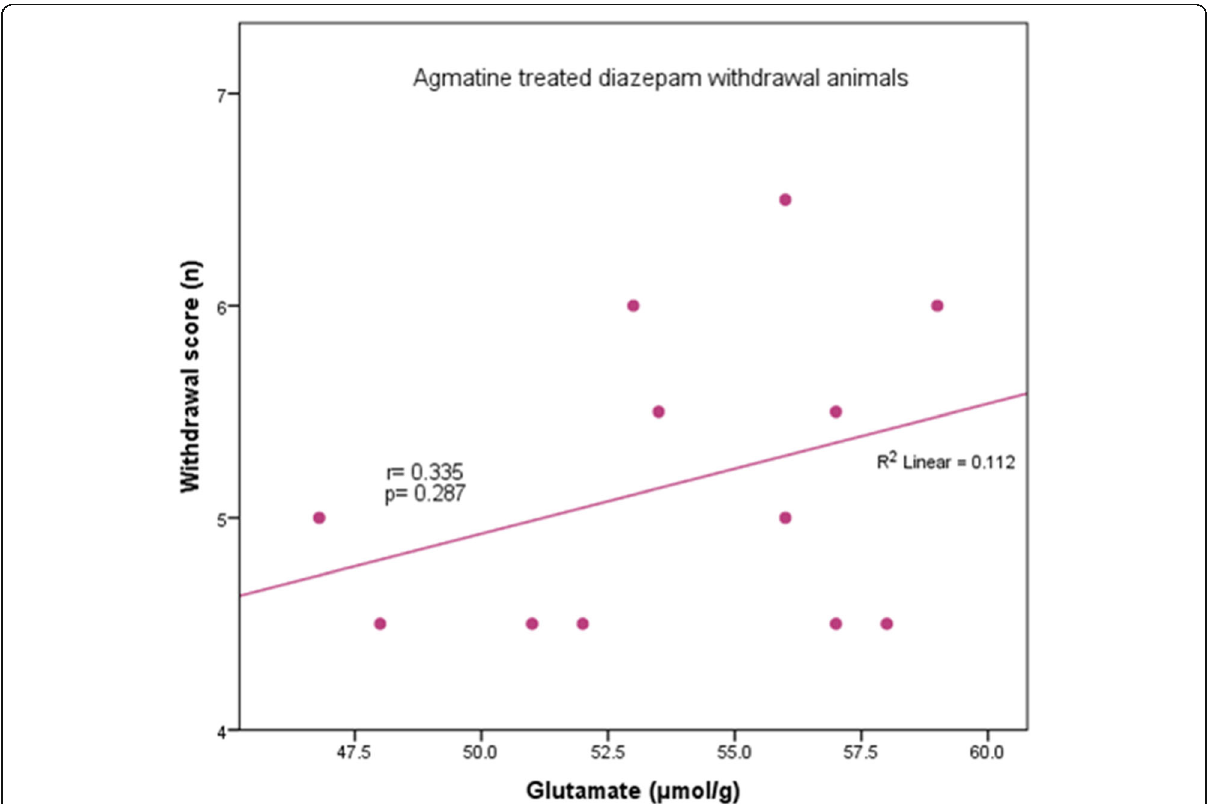
Fig. 10 Correlation between glutamate concentration and withdrawal score in agmatine-treated diazepam withdrawal